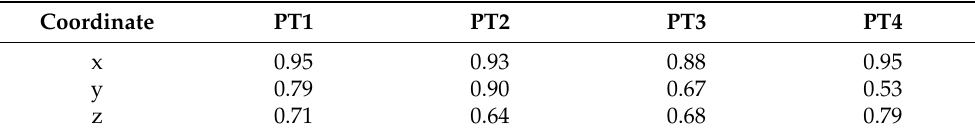
Figure 6. Time series of filtered GNSS displacement (solid line) versus the estimated autoregressive model (dashed lines) for each point and coordinate. Table 6. Linear correlation index computed between the filtered GNSS displacement time series and the autoregressive model of the displacement based on air temperature and water